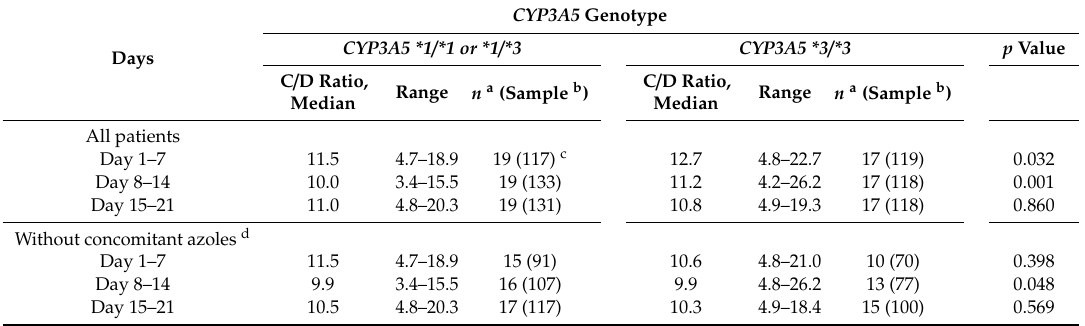
Table 2. Day + 1 to day + 21 median tacrolimus concentration / dose (C / D) ratio according to CYP3A5 genotype ( n =